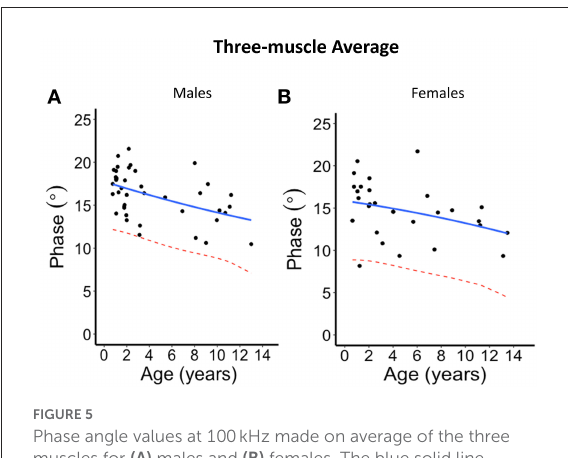
FIGURE5 Phase angle values at 100kHz made on average of the three muscles for (A) males and (B) females. The blue solid line represents the normal fit generated from the second-degree polynomial regression through the log-transformed data while the red dotted lines represent the parallel curve that is the lower limit of normal based on the 95% prediction limit of the quadrative